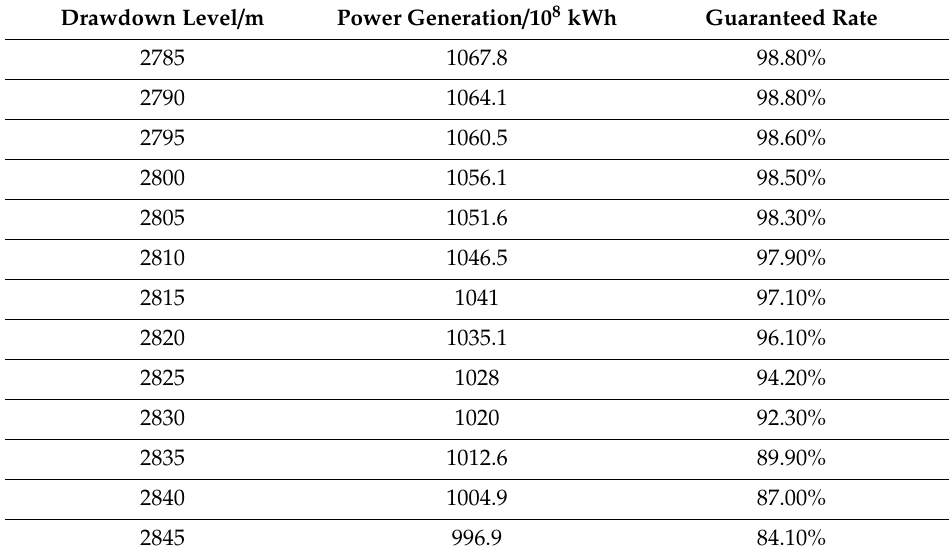
Table 5. Results of cascade power generation and guaranteed rate under di ff erent drawdown levels. Drawdown Level /